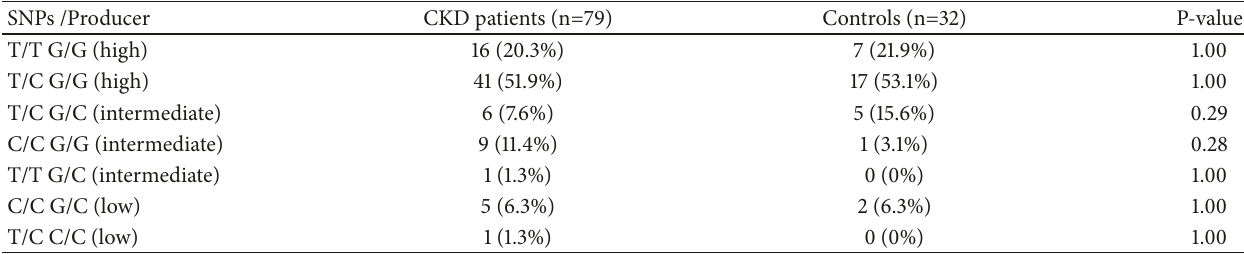
Table 5: TGF- 𝛽 1 T-869C and G-915C SNPs distribution and frequency in study